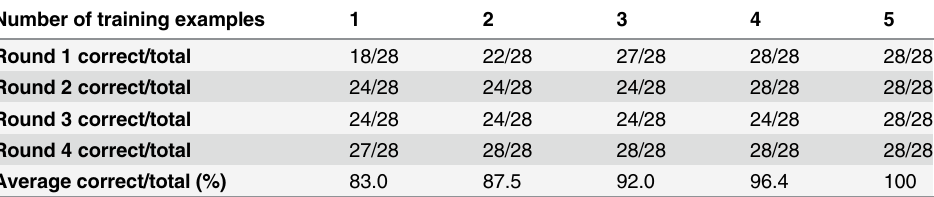
Table 5. Number of tasks that are performed correctly by the system on the virtual environment data- set over the total number of assigned tasks in the test stage of the cross validation rounds, as a func- tion of the number of training examples used in the training